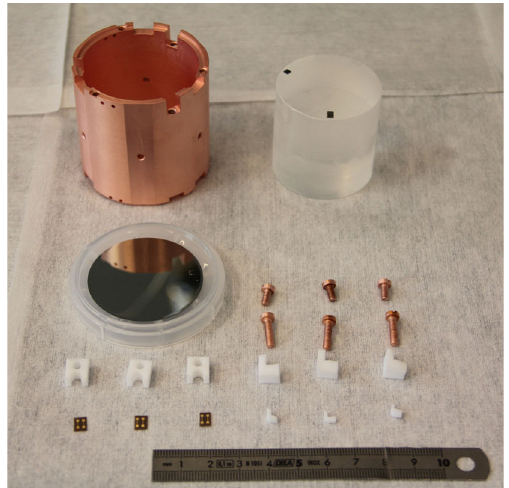
Fig. 3 All components used to assemble a CUPID-Mo single detec- tor module: a copper holder, a Li 2 100 MoO 4 crystal with glued NTD and heater, a Ge LD with NTD, the copper screws, the PTFE spacers and fixing elements, the Kapton foil with golden pads. Note that the reflecting film is not shown here